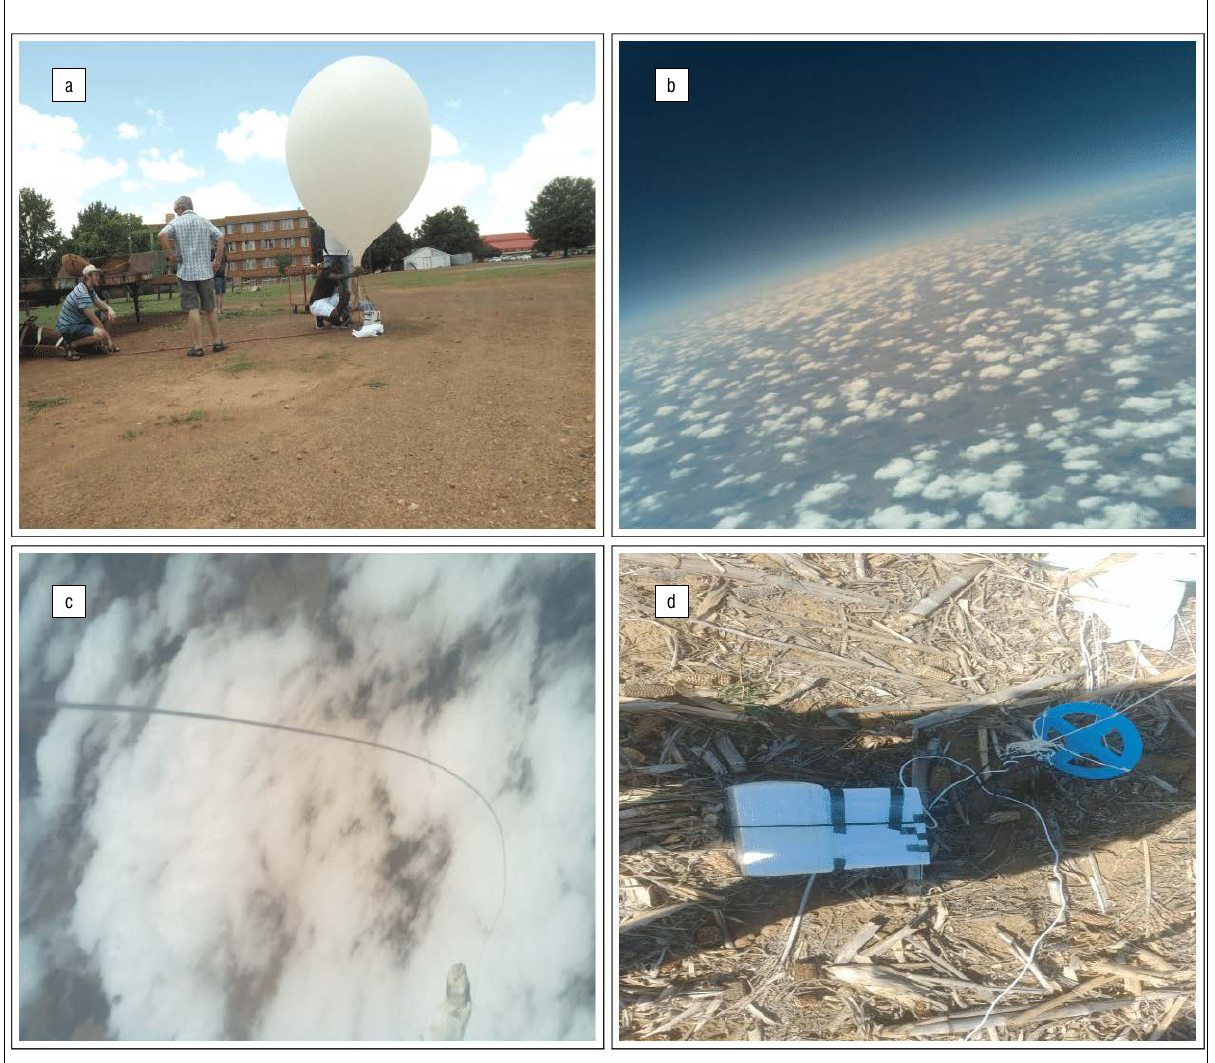
Figure 5: High-altitude balloon launch: (a) launch site, (b) Earth horizon, (c) the burst balloon captured during the descent, and (d) landing